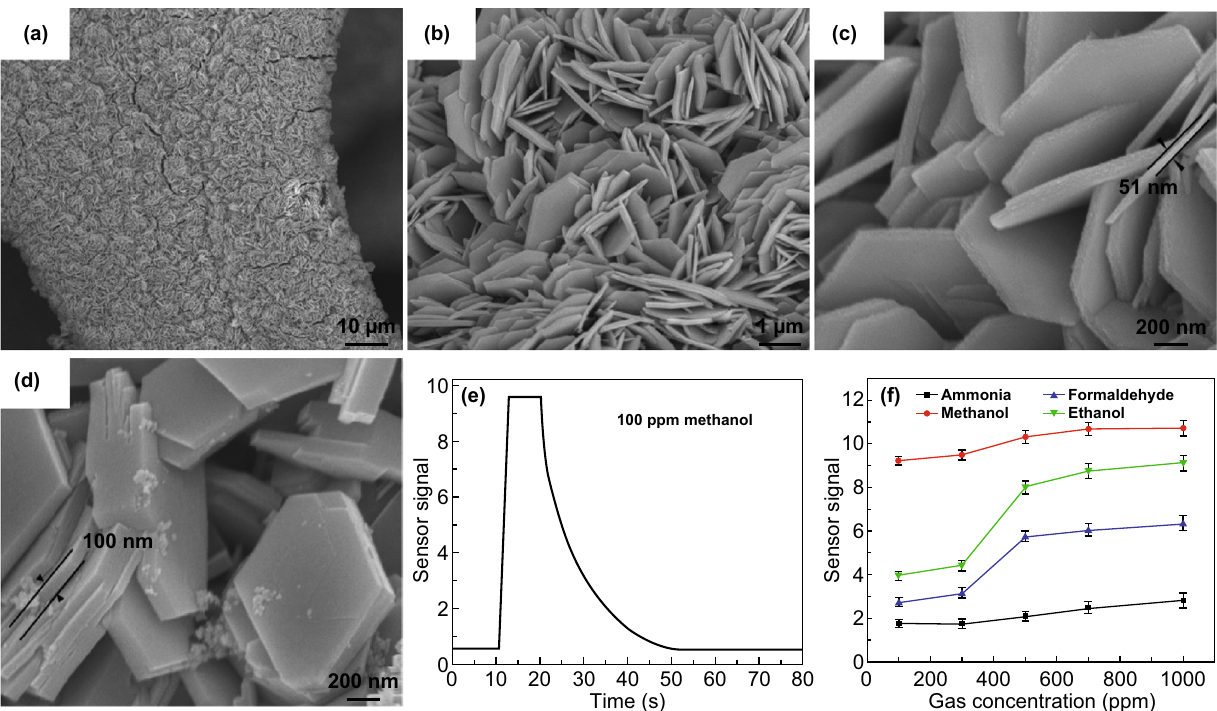
Fig. 7 a – c SEM images at different magnification of hexagonal ZnCo 2 O 4 grown on Ni foam using 0.2 mmol urea, d SEM image showed the increase in the sheets thickness with increasing the urea content, e sensor signal–time curve showing the fast response and slow recovery of the sensor, f the effect of the concentration on the sensor signal for various gases. Adapted with permission from Ref. [203]. Copyright 2018 Else-